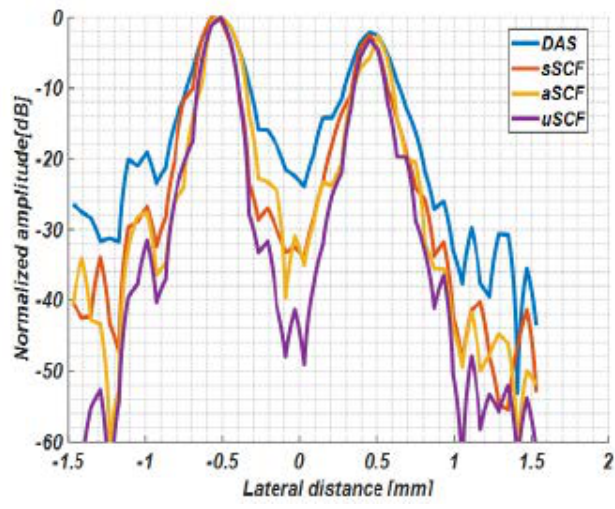
Figure 6. The lateral variations of the two rightmost points in the phontom.